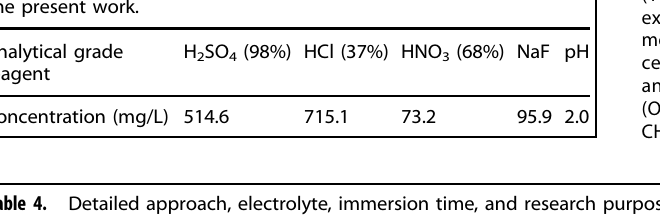
Table 4. Detailed approach, electrolyte, immersion time, and research purpose of the electrochemical measurements.